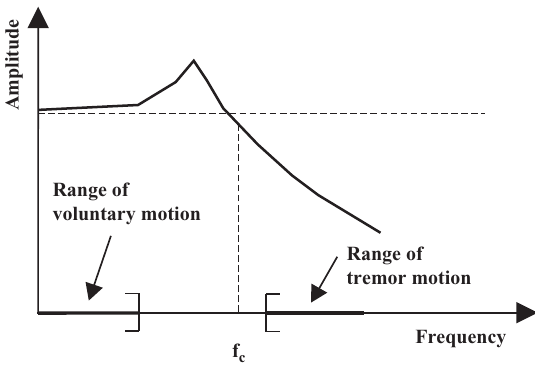
Figure 4 The musculo-skeletal system is modelled as a second order biomechanical system. The active orthosis is used to modify the apparent biomechanical characteristics of the upper limb so that the cut-off frequency, f c , lies between the frequency range of voluntary and tremor motion.